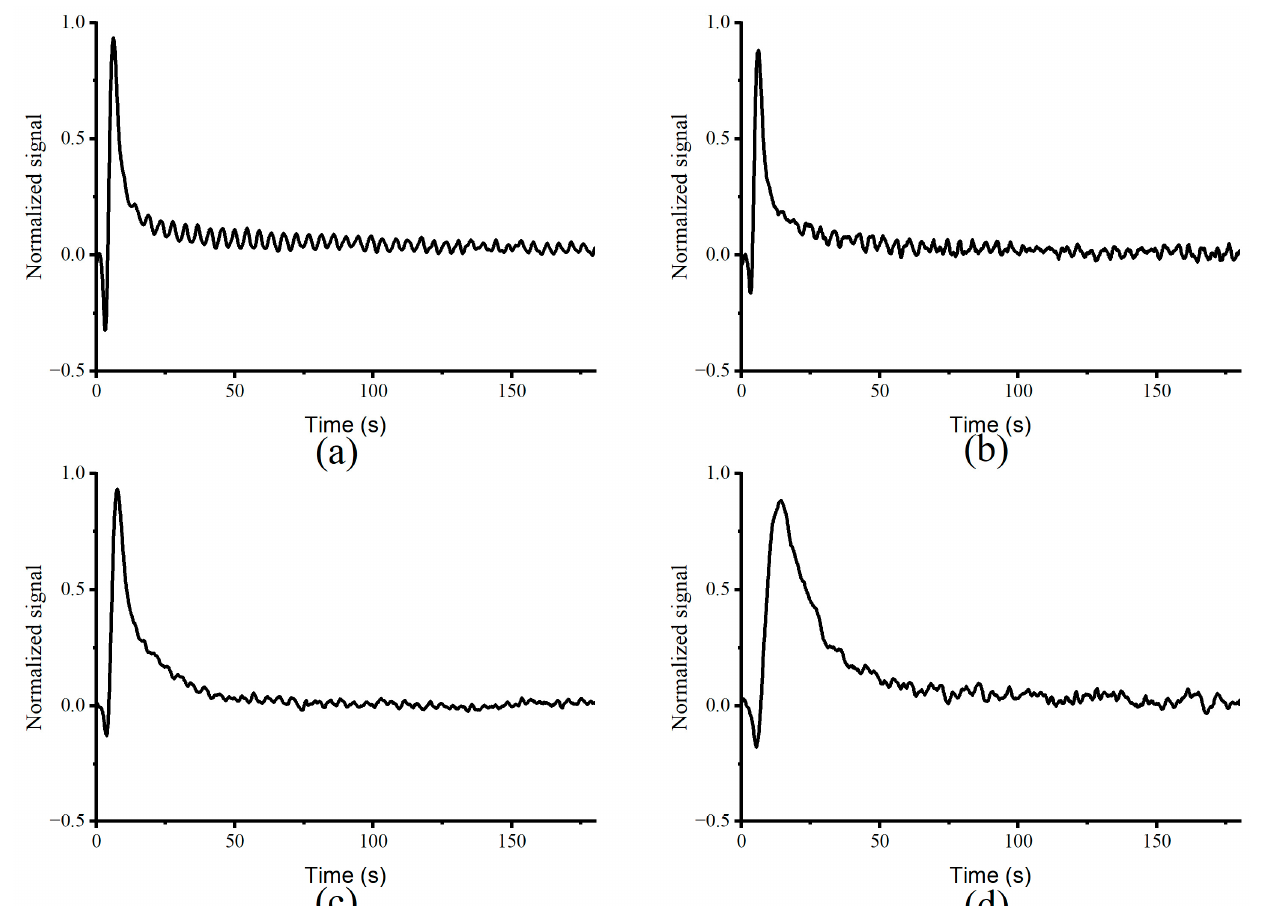
Figure 8. Averaged normalised signals for all designs at maximum gas flow rate (257–310) m 3 /h; ( a ) Design 1: Four-inch connection; ( b ) Design 2: Six-inch connection; ( c ) Design 3: Box connection; ( d ) Design 4: Conical drying chamber.